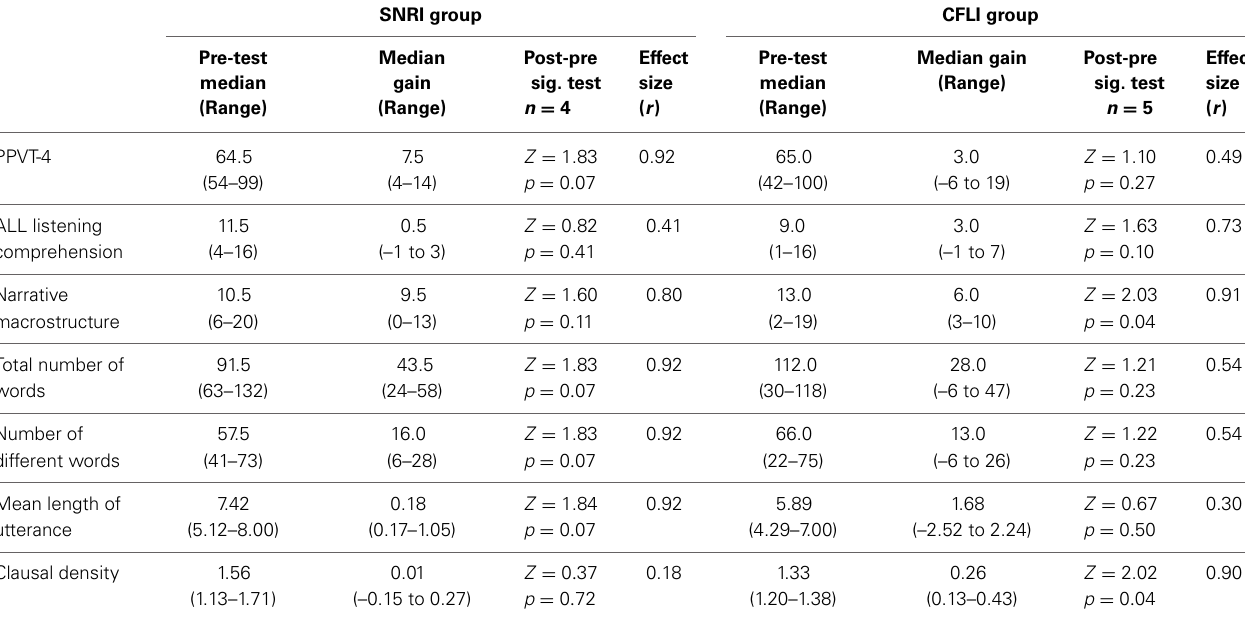
Table 2 | Pre- and post-test assessments of vocabulary, listening comprehension, narrative macrostructure, and narrative